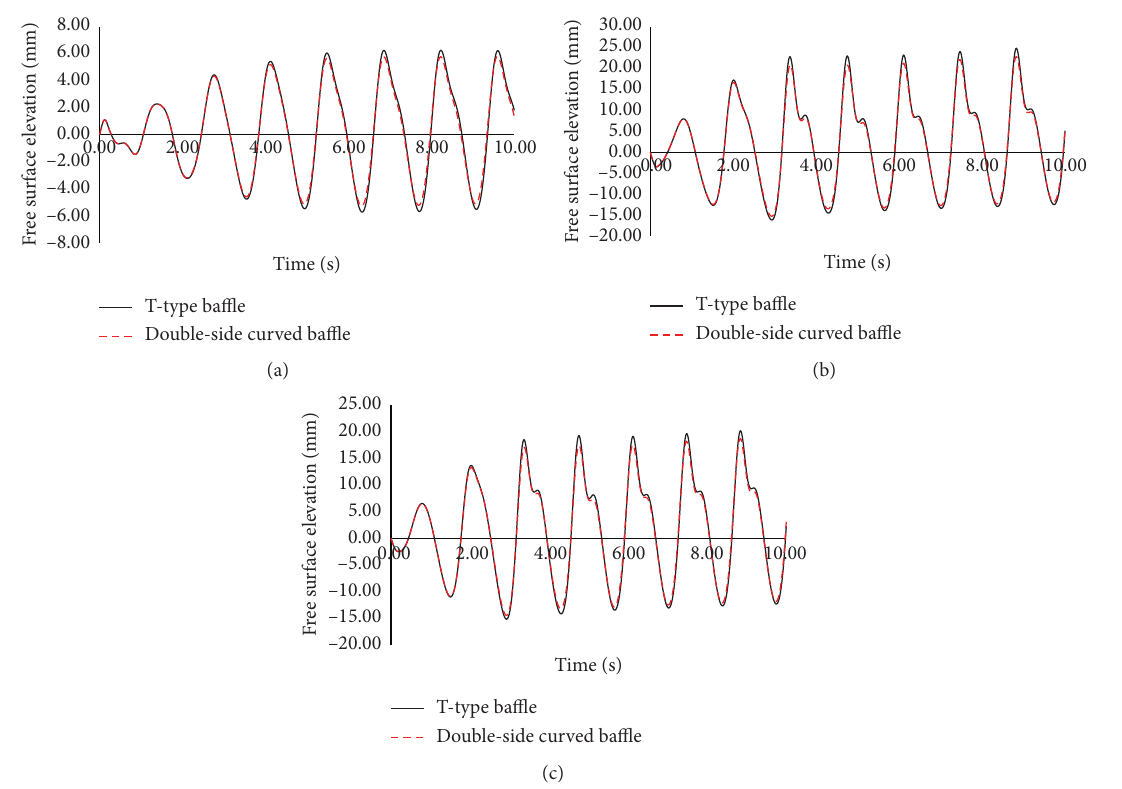
Figure 12: Comparisons of time history of wave height under different motion styles of the tank with T-type baffle and double-side curved baffle and (f) � 0.73 Hz: (a) surge excitation with A � 0.002m; (b) pitch excitation with θ � 1 ° ; (c) coupled excitation of surge and pitch with A � 0.002m and θ � 1 ° .